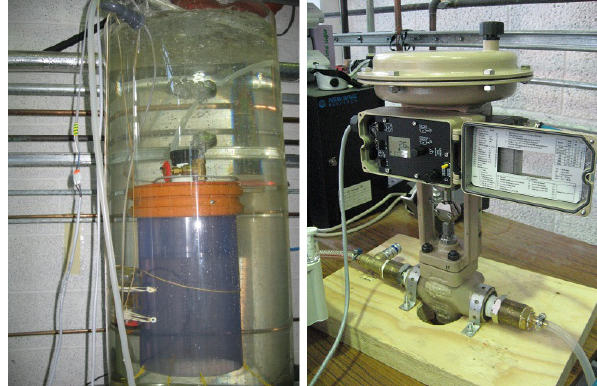
Figure 2: Left: Water tank with lifting body.